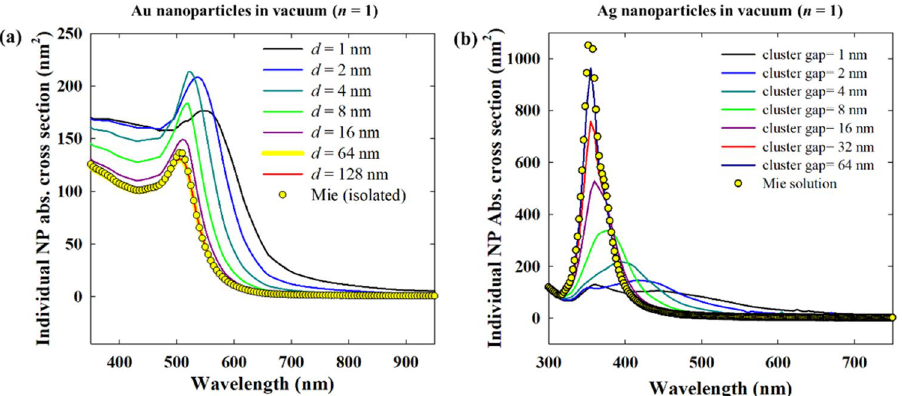
Figure 6. Effect of interparticle gap ( d ) in monolayer 2D hexagonal close packed arrays of 20 nm Ag nanoparticles in vacuum ( n = 1), comparing the absorption cross section per